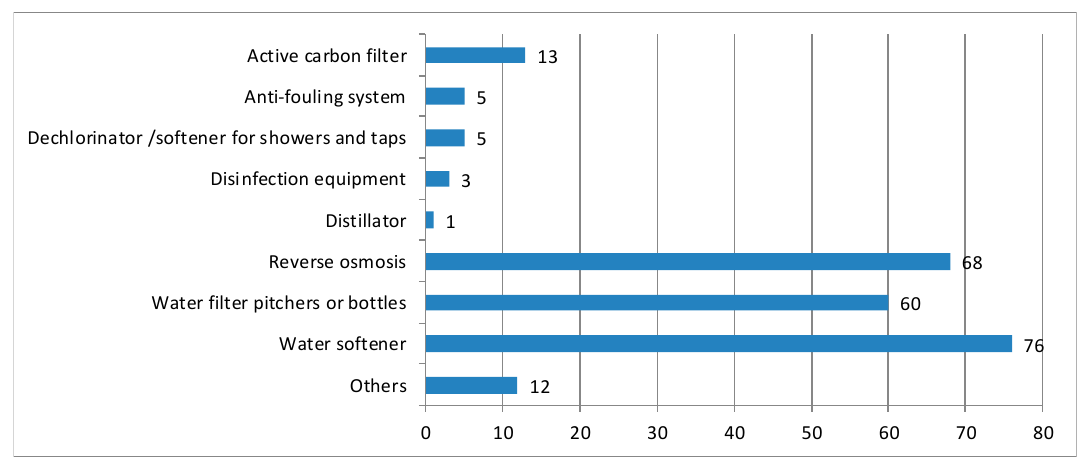
Figure 2. Frequency of households that have in-home water treatment systems.